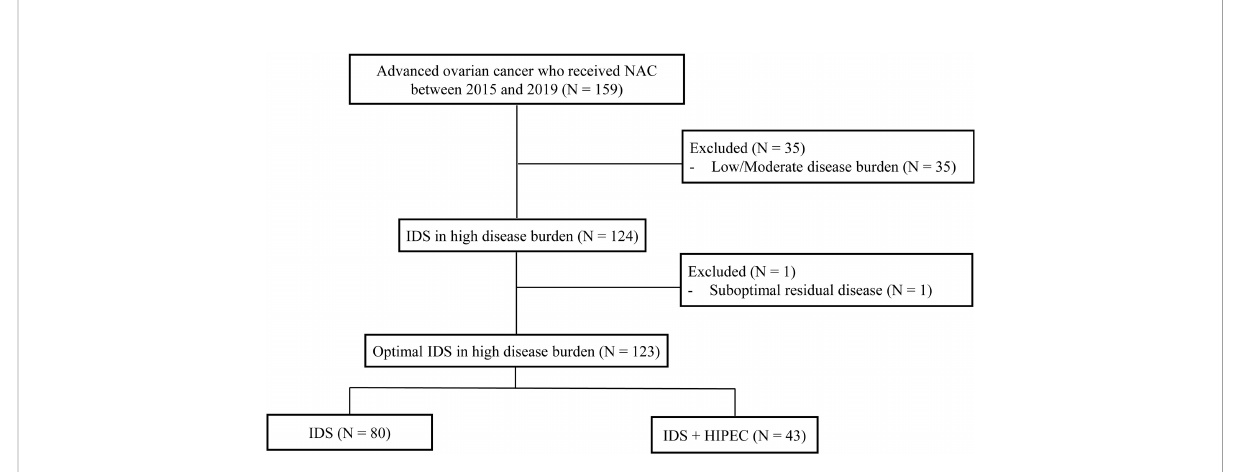
FIGURE 1 Flow diagram of the study population. NAC, neoadjuvant